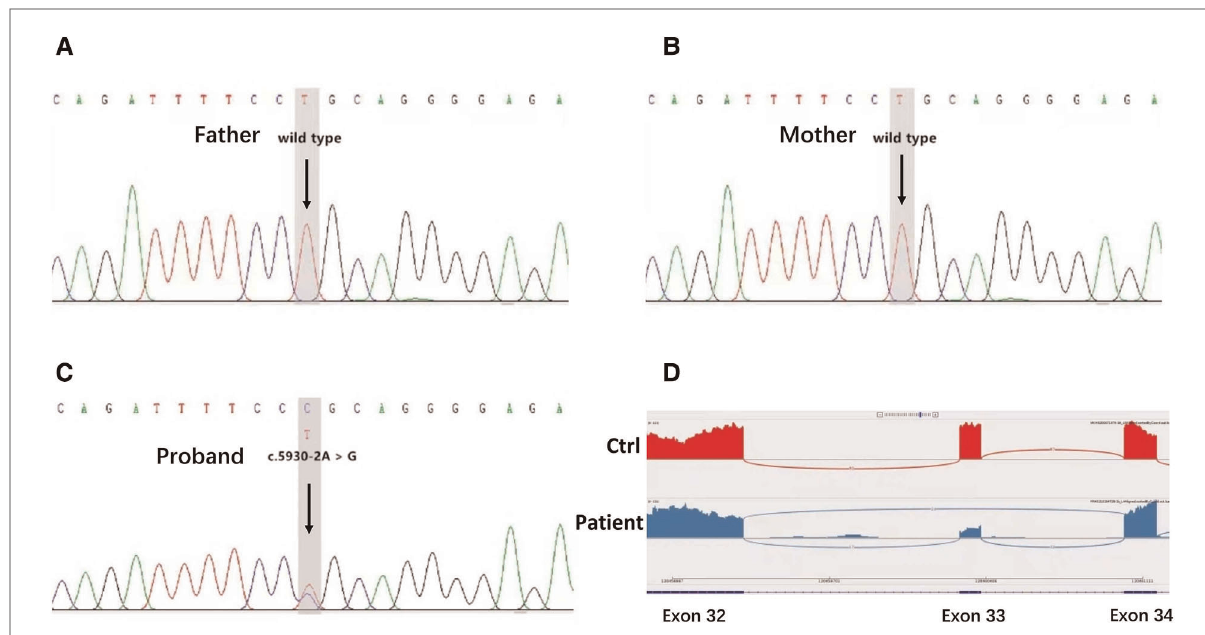
FIGURE 3 Genetic test results. ( A,B ) Sanger sequencing of the targeted NOTCH 2 variation in the proband ’ s family members. The arrows indicate that the patient ’ s parents possessed the wild-type genotype for NOTCH 2. ( C ) Identi fi cation of a NOTCH 2 pathogenic variant in the patient. The arrows indicate an alteration from A to G in the NOTCH 2 gene of the patient. ( D ) Transcriptome sequencing con fi rmed that the mutation of this gene site would affect the splicing of NOTCH 2 mRNA and lead to exon 33